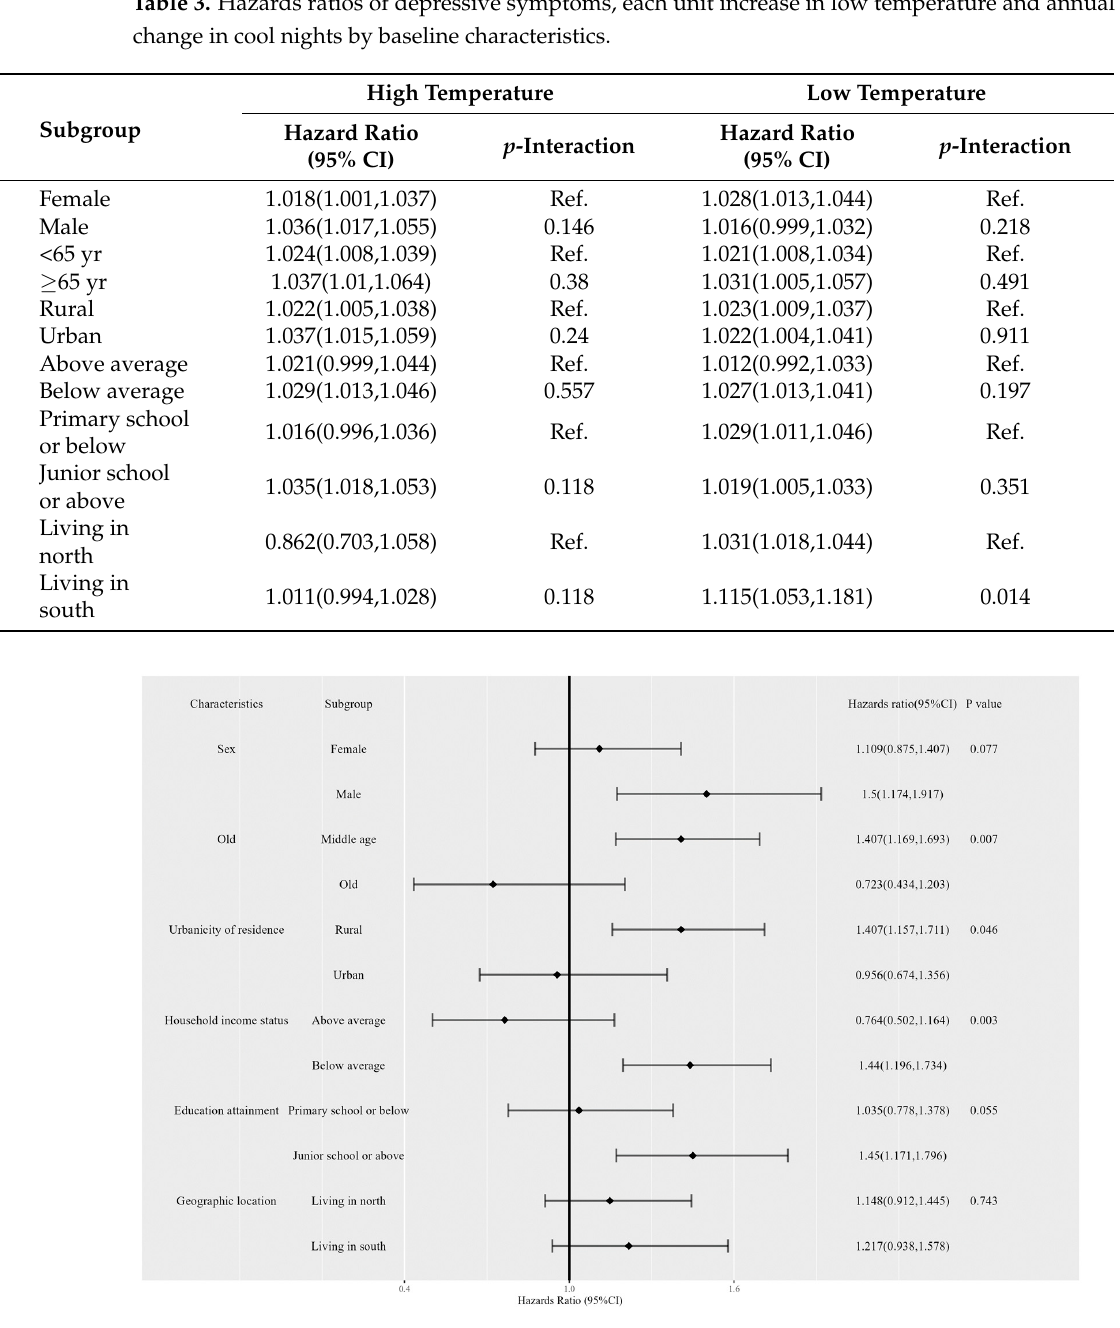
Figure 3. Hazards ratios of depressive symptoms, each percent increase in annual change in tropical nights by baseline characteristics.